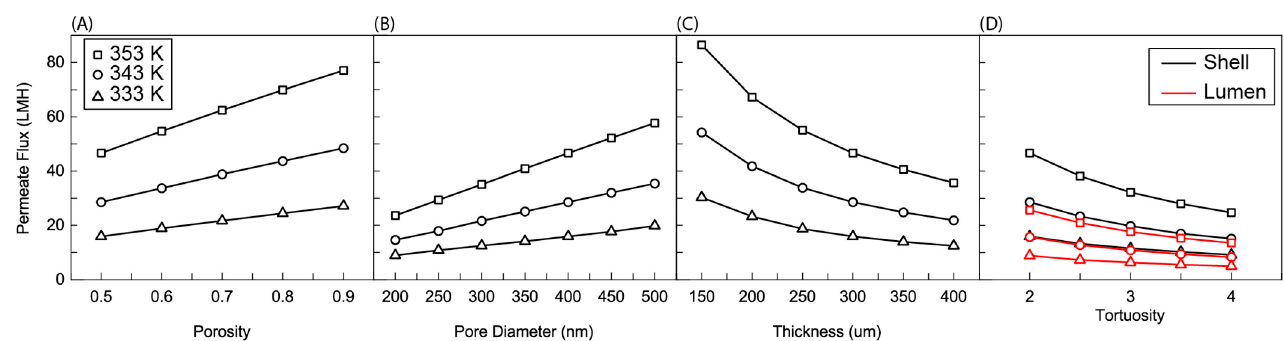
Figure 4. Average permeate flux as a function of ( A ) porosity, ( B ) nominal pore size, ( C ) membrane thicknesses, and ( D ) effective tortuosities. In ( A – C ) the feed was charged to shell side, ( D ) Shows for both cases, charging feed into the shell and lumen. Here, the R / a ratio is fixed at 0.35, the membrane length is 5 cm, feed velocity is 5 m/s, and the permeate pressure is 5 kPa.